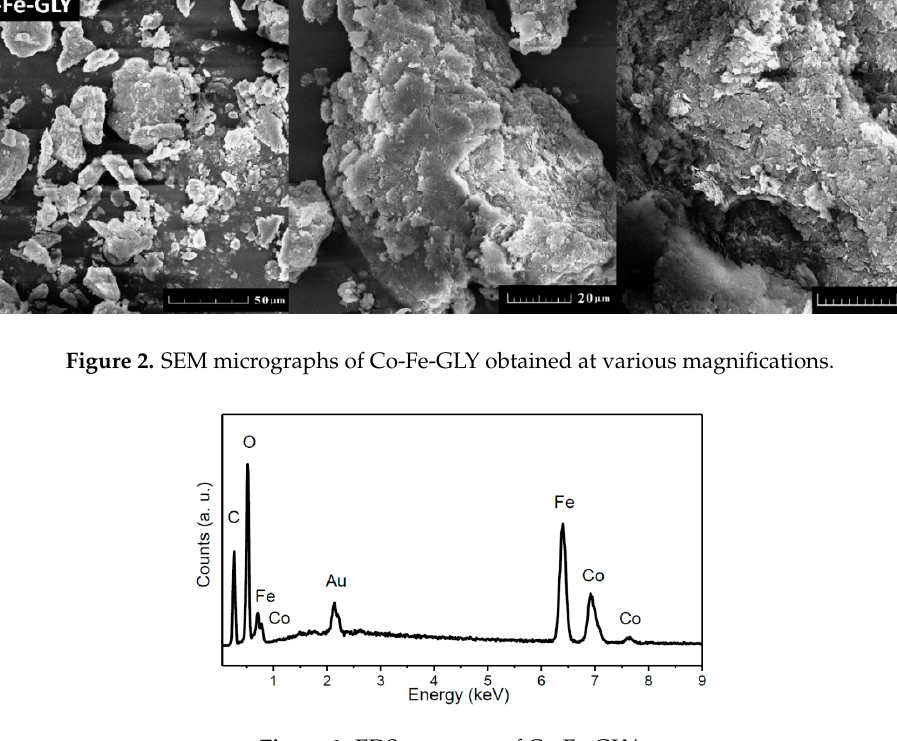
Figure 3. EDS spectrum of Co-Fe-GLY.